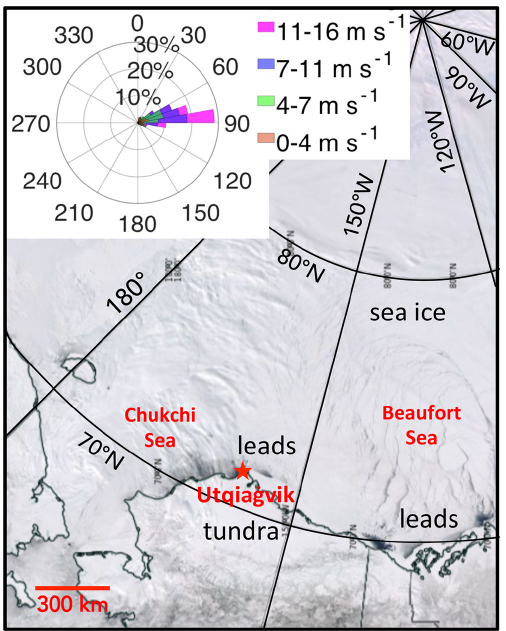
Figure 1. Image of the North Slope of Alaska and Beaufort and Chukchi seas on 6 April 2016 from the Terra satellite Moderate Res- olution Imaging Spectroradiometer (MODIS). The dark regions and cracks correspond to leads surrounded by sea ice. The inset plot de- picts the percentage distribution of observed wind speeds and direc- tions, measured at a 9.7m height at the Utqia˙gvik tundra site from 3 April to 7 May 2016. This figure is modified from NASA World- view (https://worldview.earthdata.nasa.gov/, last access: 24 Novem- ber